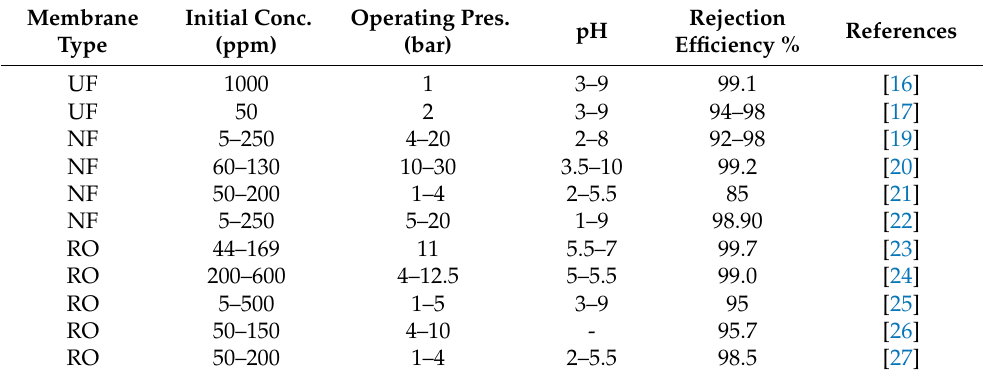
Table 1. Review of previous investigations on nickel (II) removal by different treatment techniques. Membrane Initial Conc. Operating Type (ppm)